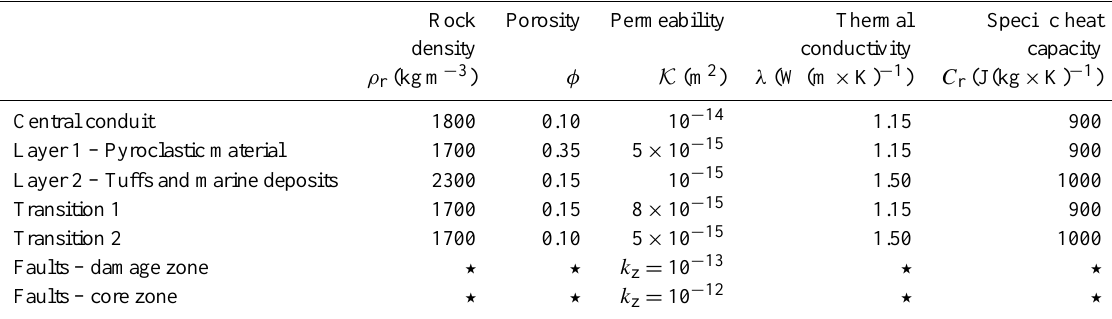
Table 1. Hydrological parameters for the domain of Fig. 2: rock density ρ r (kgm − 3 ), porosity φ , permeability K (m 2 ), thermal conductivity almost 2 orders of magnitude in the fault damage zone and by 3 orders of magnitude in the core of the faults. In other respects the fault zones have the same hydrological characteristics as the matrix (star symbol (cid:63) ).